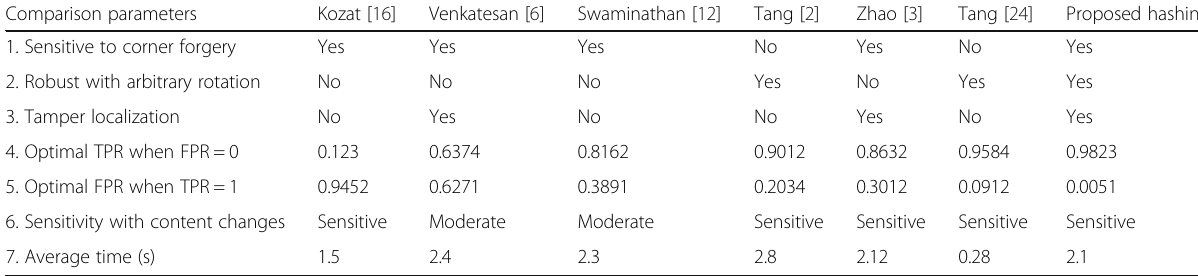
Table 12 Comparison of the proposed method with some state-of-the-art methods Comparison parameters